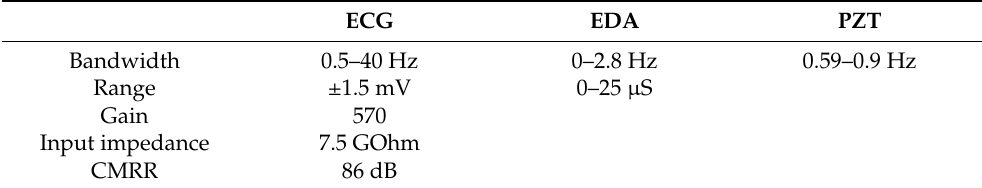
Table 3. Specifications of the ECG, EDA, and PZT sensors used in the